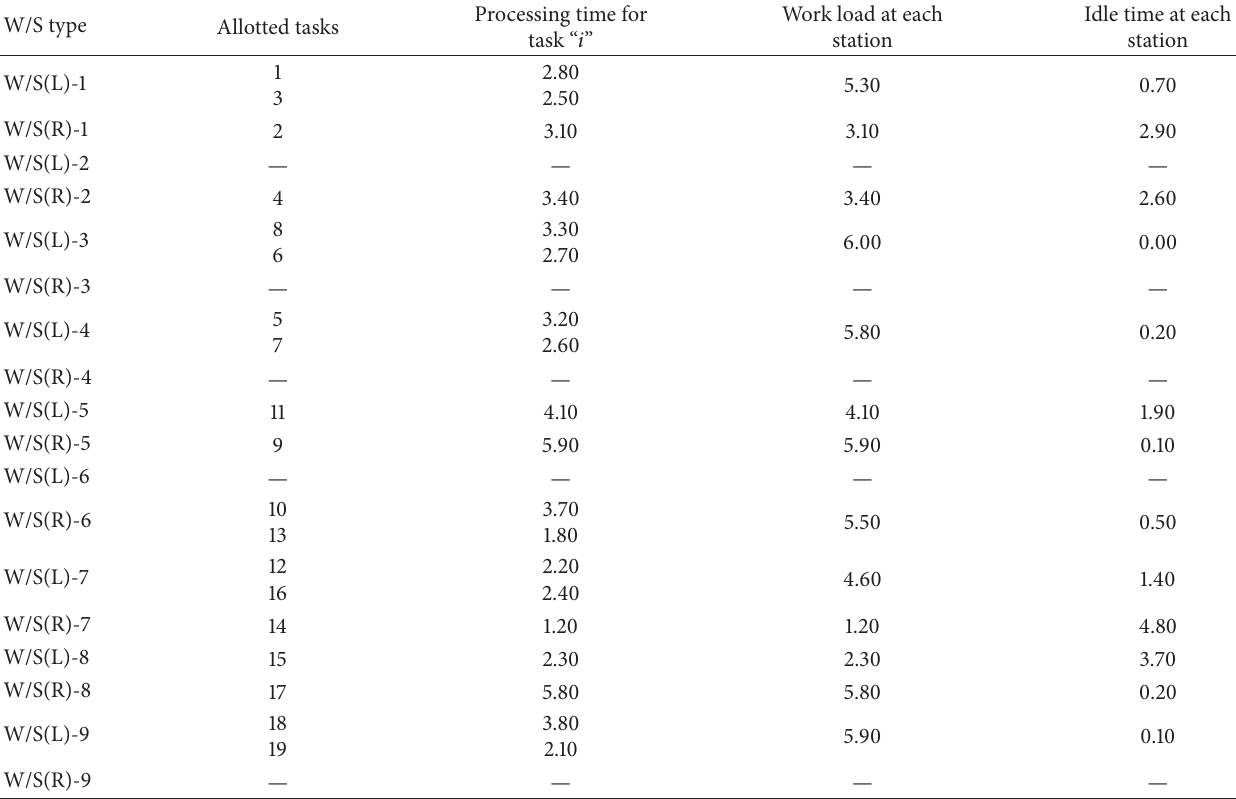
Table 5: Allocation of tasks for 3rd assignment of P19 (CT =